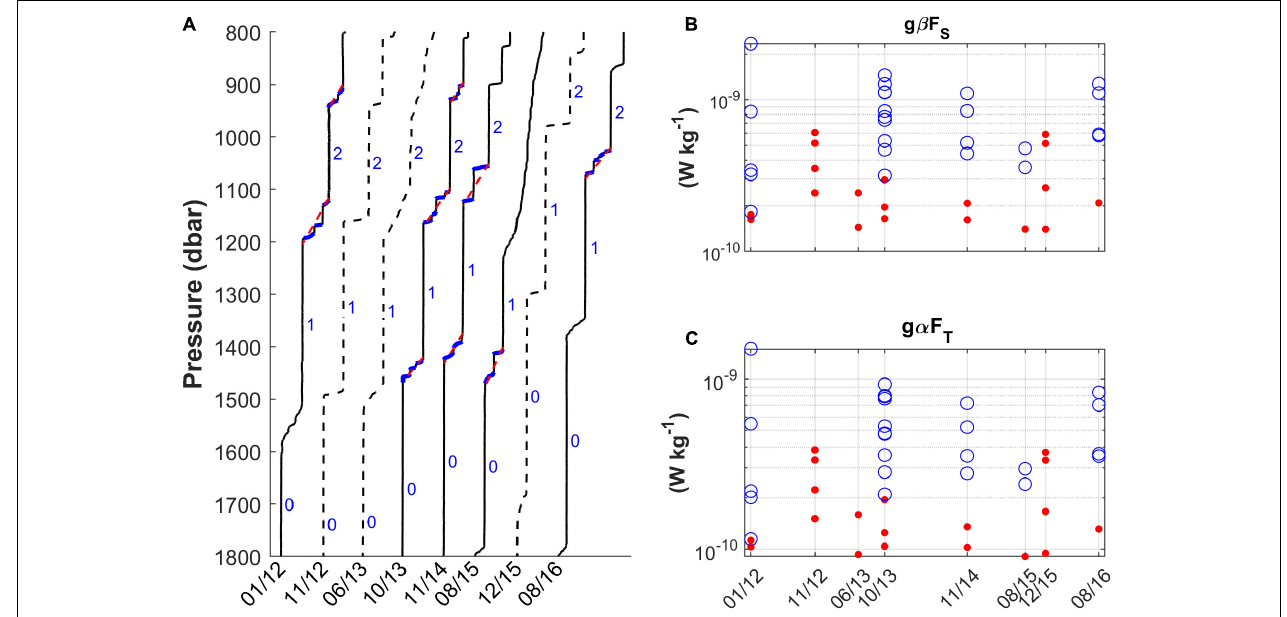
FIGURE 13 | (A) Evolution of the Tyrrhenian staircases between 800 and 1800 dbar from January 2012 to August 2016. Steppy interfaces are delineated in blue. The dashed red lines represent their approximations, with the upper and lower limits demarcated. (B,C) Comparison of the estimated contributions of salt and heat to the buoyancy flux (RS12) for the steppy (blue circles) and rectified (solid red circles) interfaces. The axes expressing the fluxes are set to the logarithmic